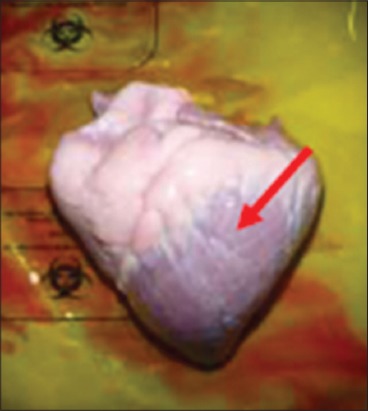
Congested and hemorrhagic heart.